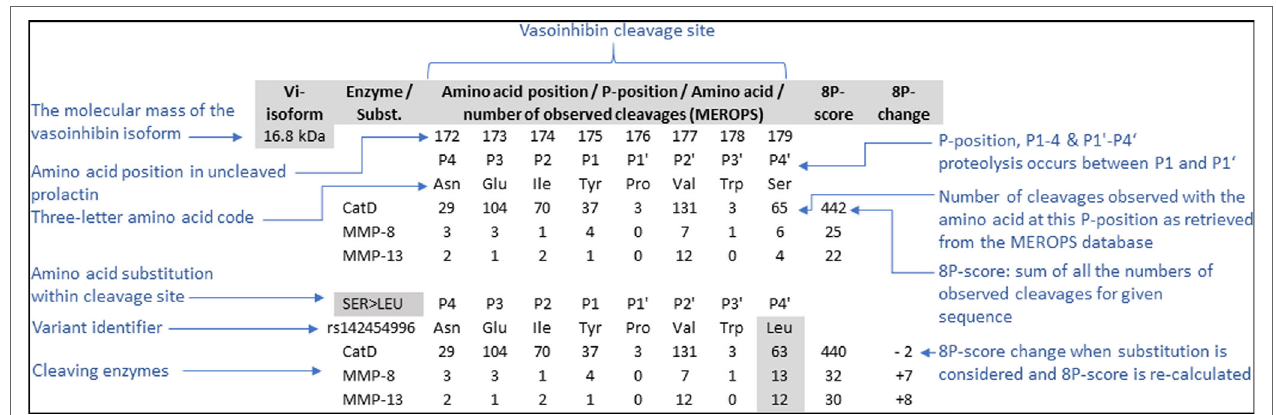
FigUre 1 | To project the consequences of single amino acid substitutions in vasoinhibin-generating cleavage sites of the prolactin amino acid sequence, an 8P-score was used. The score consists of the sum of the numbers of observed cleavages by the enzyme indicated with a particular amino acid on each of the eight positions (P1’–P4’, P1–P4), retrieved from the MEROPS database (28). The cleavage occurs between positions P1’ and P1. The effect of amino acid substitutions was projected by recalculation of the score after replacement of the amino acid and adjusting the corresponding number of observed